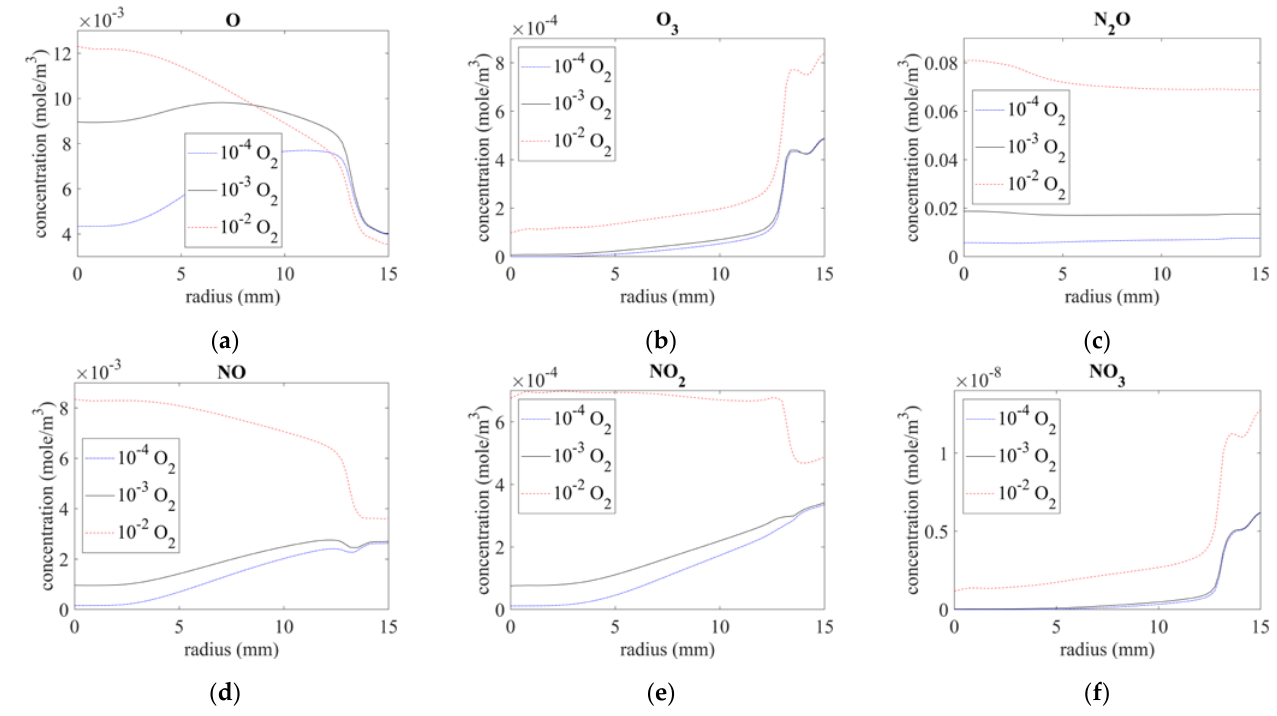
Figure 8. Species distribution on surface of ( a ) O, ( b ) O 3 , ( c ) N 2 O, ( d ) NO, ( e ) NO 2 , and ( f ) NO 3 .